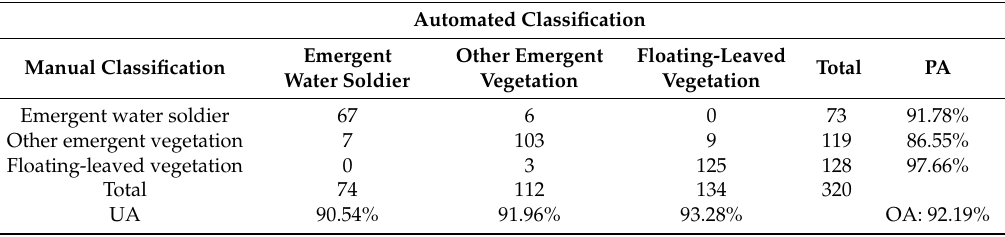
Table 5. Confusion matrix for the top submerged classification across all five study sites. PA = producer’s accuracy; UA = user’s accuracy; OA = overall accuracy .